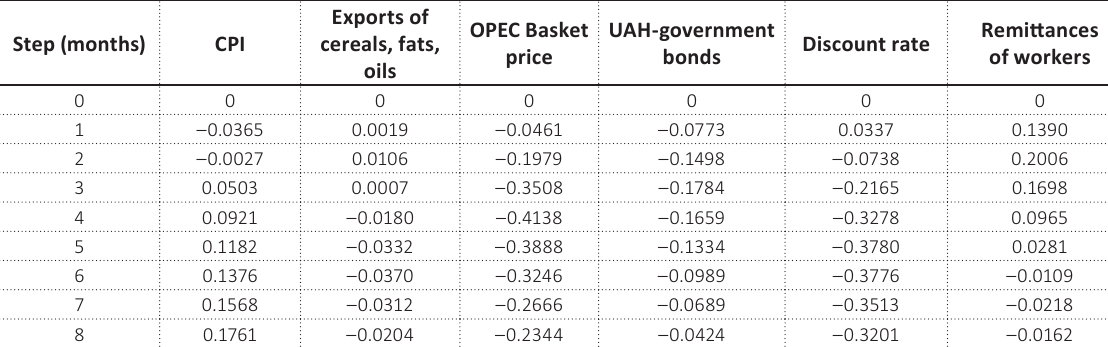
Table 6. Impulse reaction for VAR (2) model, % Step